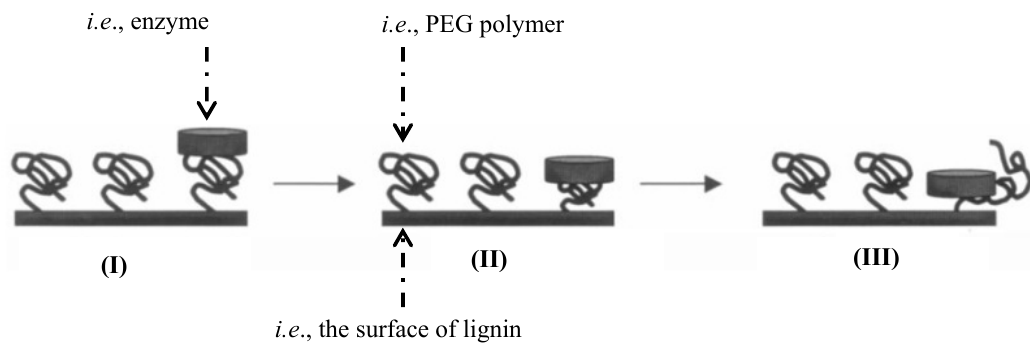
Figure 2. The escape transition following protein compression of a PEG polymer that has been adsorbed to the surface in mushroom regime. (Adopted from Allen et al. [62], based on Steels et al. [63]). Uncompress ( I ), Compressed ( II ), Chain escape ( III